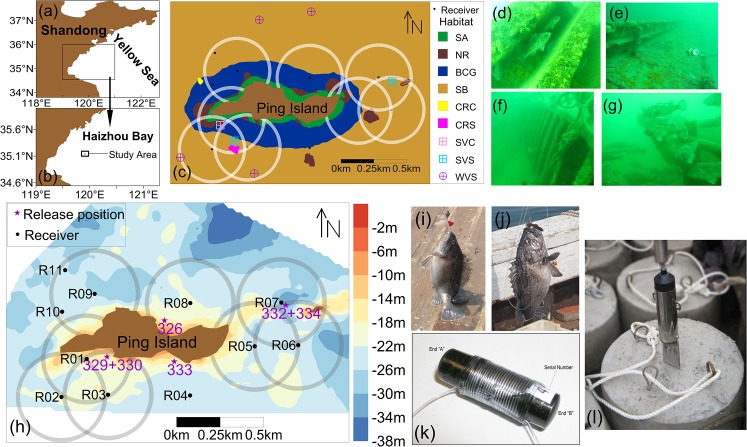
The study area location, habitat types, the tag wrapping method and the receiver mooring system.(a) The location of Haizhou Bay in the Yellow Sea. (b) The location of study area. (c) Bottom habitat types around Ping Island and detecting range of receivers. (d) Cement reef. (e)-(f) Sunken steel vessels. (g) Sunken wooden vessel. (h) The acoustic receiver array deployment, receiver positions and detecting range, the fish release positions and depth range (m) around Ping Island. (i)-(j) Two S. schlegelii captured via hook and line by local fishermen. (k) The wrapping method for attachment of the acoustic tags and (l) The omnidirectional receiver and the mooring system. In panel (c), the halos around receivers represent a 250-m detection radius, and 3 receivers (R04, R10 and R11) without halo were lost. Habitat are named as seagrass at rocky bottom dominated by Sargassum sp. (SA), natural reef (NR), boulder, cobble and gravel bottoms (BCG), sandy bottom (SB), cement reef at cobble bottom (CRC), cement reef at sandy bottom (CRS), sunken steel vessel at cobble bottom (SVC), sunken steel vessel at sandy bottom (SVS) and sunken wooden vessel at sandy bottom (WVS).